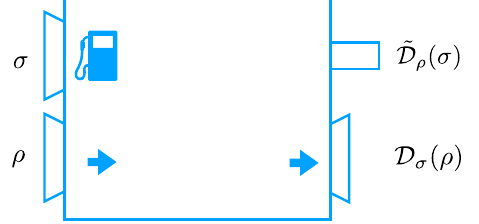
FIG. 2. Single instance of “ universal dephasing machine. ” We interpret the process ρ ⊗ σ → U ð ρ ⊗ σ Þ U † as a dephasing machine that takes the state σ as fuel and transfers the input state ρ into the output state D σ ð ρ Þ and “ waste ”